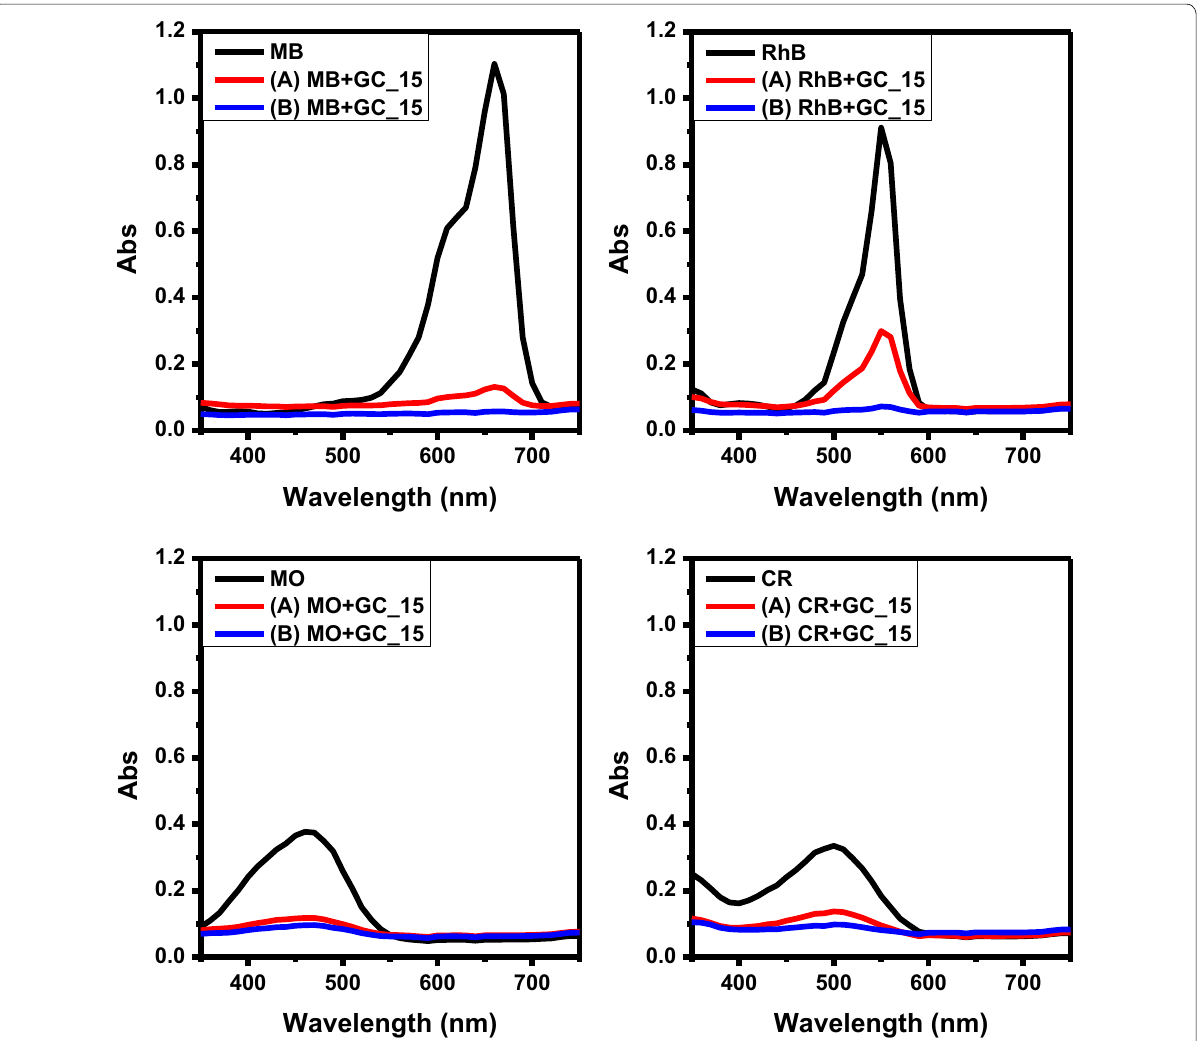
Fig. 8 The UV–Vis adsorption spectra recorded for the model dye solutions before and after filtration using the GC_15 composite hydrogel column: a direct filtration and b filtration after 24 h of